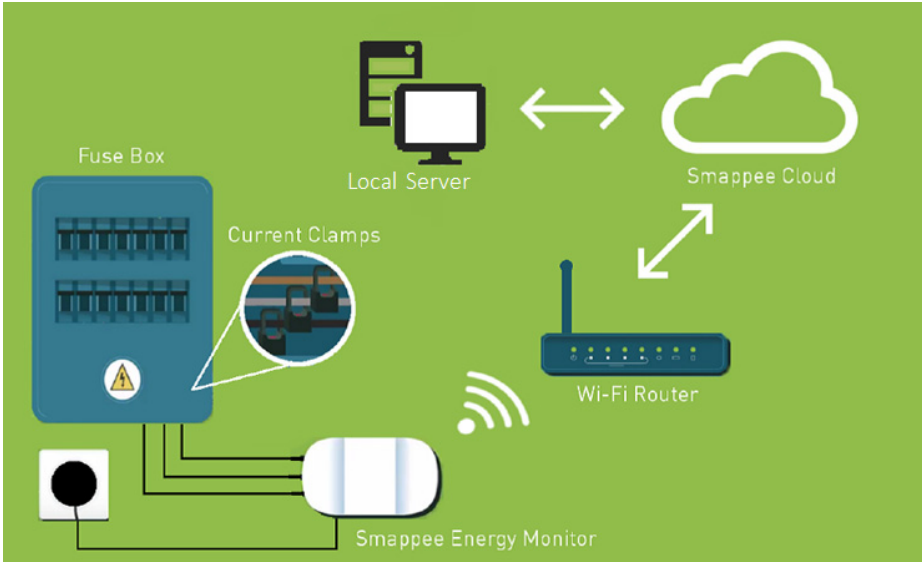
Figure 2. Power monitoring system structure.